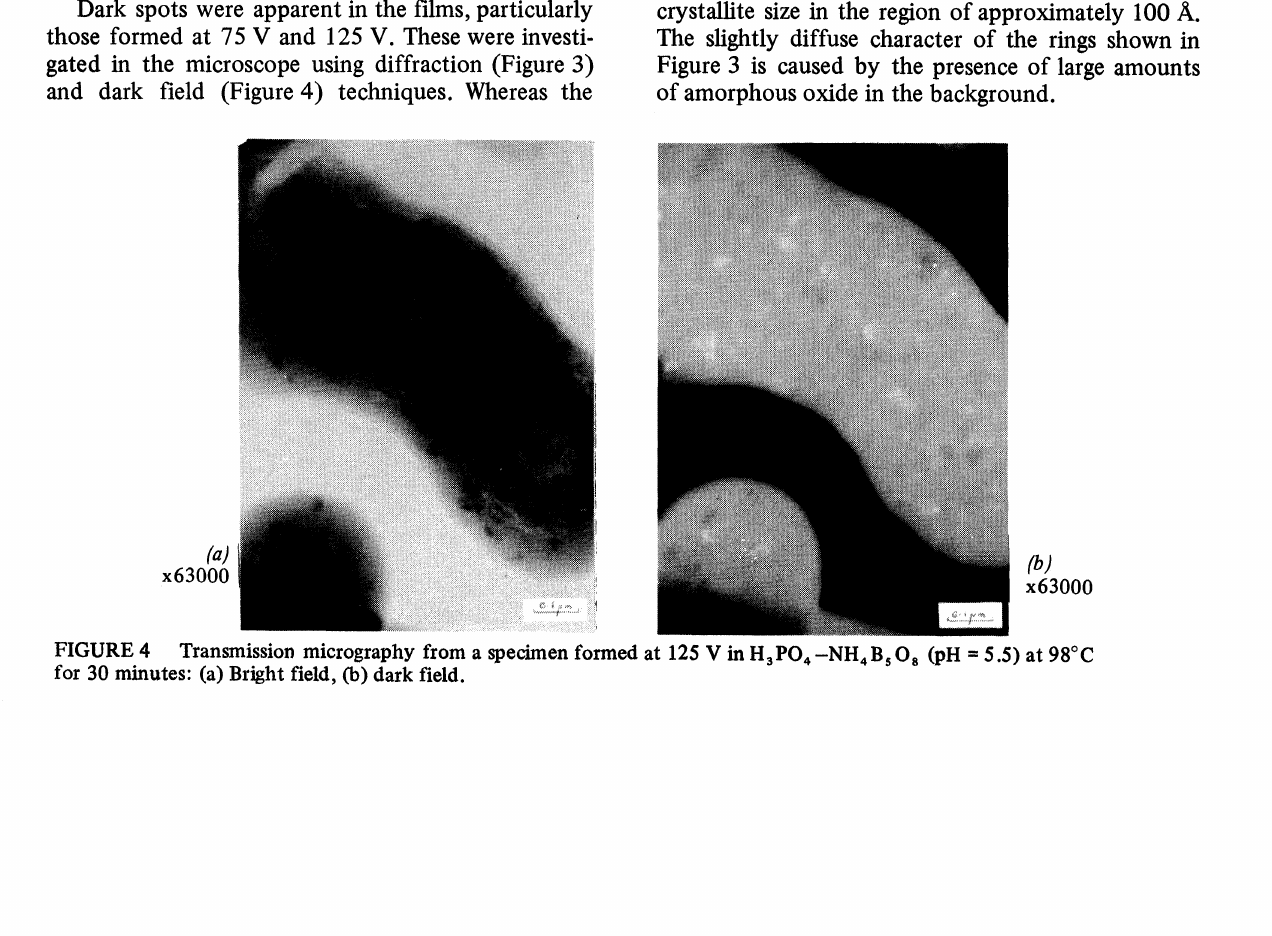
FIGURE 3 Electron diffraction pattern from a specimen formed at 125 V in H3PO4-NH4BsO (pH 5.5) at 98C for 30 minutes.